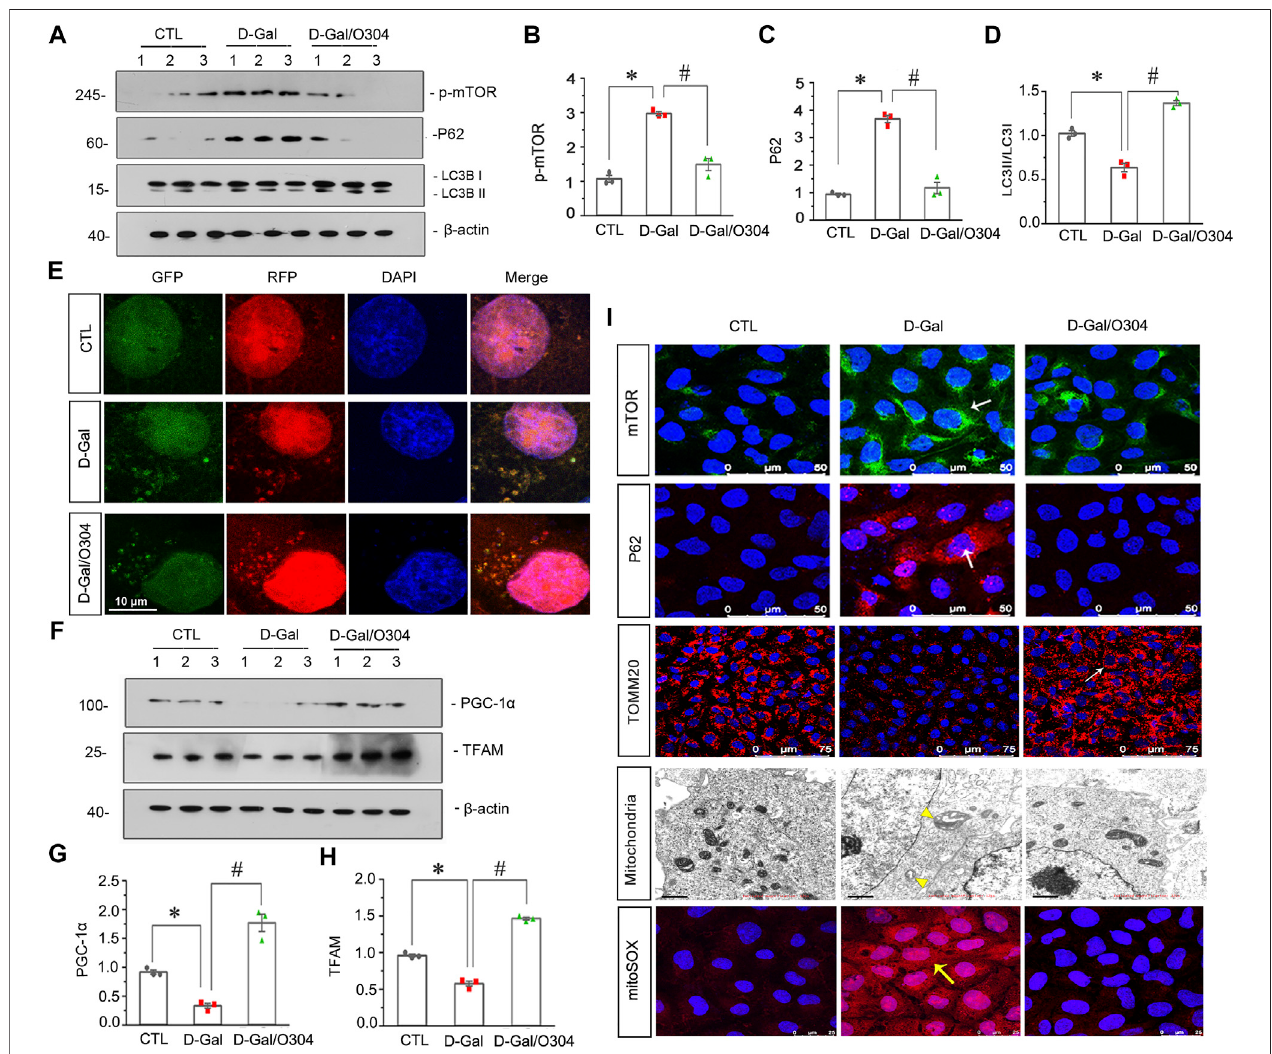
# p < 0.05 versus D-Gal-treated group alone ( n = 3). (E) Representative micrographs show that O304 promoted acidic-pH LC3B-positive autophagolysosomes (red fl uorescence).HKC-8cellswerepre-transfectedwithlentivirusesexpressingRFP-GFP-LC3Bfor12 h,and werethenstimulated byD-Gal(10 mg/ml)for60